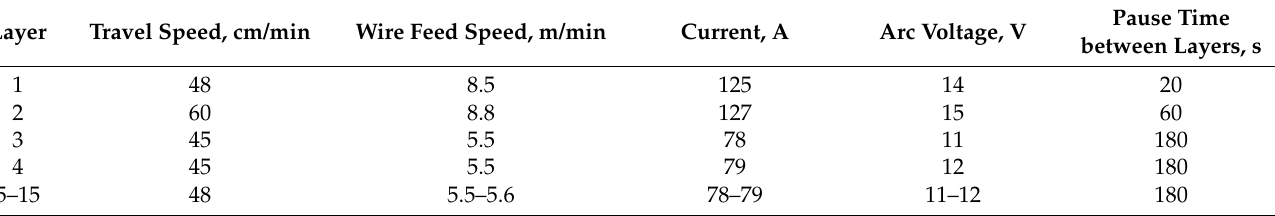
Figure 2. ( a ) Thermocouples location and the sequence for walls manufacturing (all dimensions are in millimeters); ( b ) deposition direction. Table 2. Process parameters for each